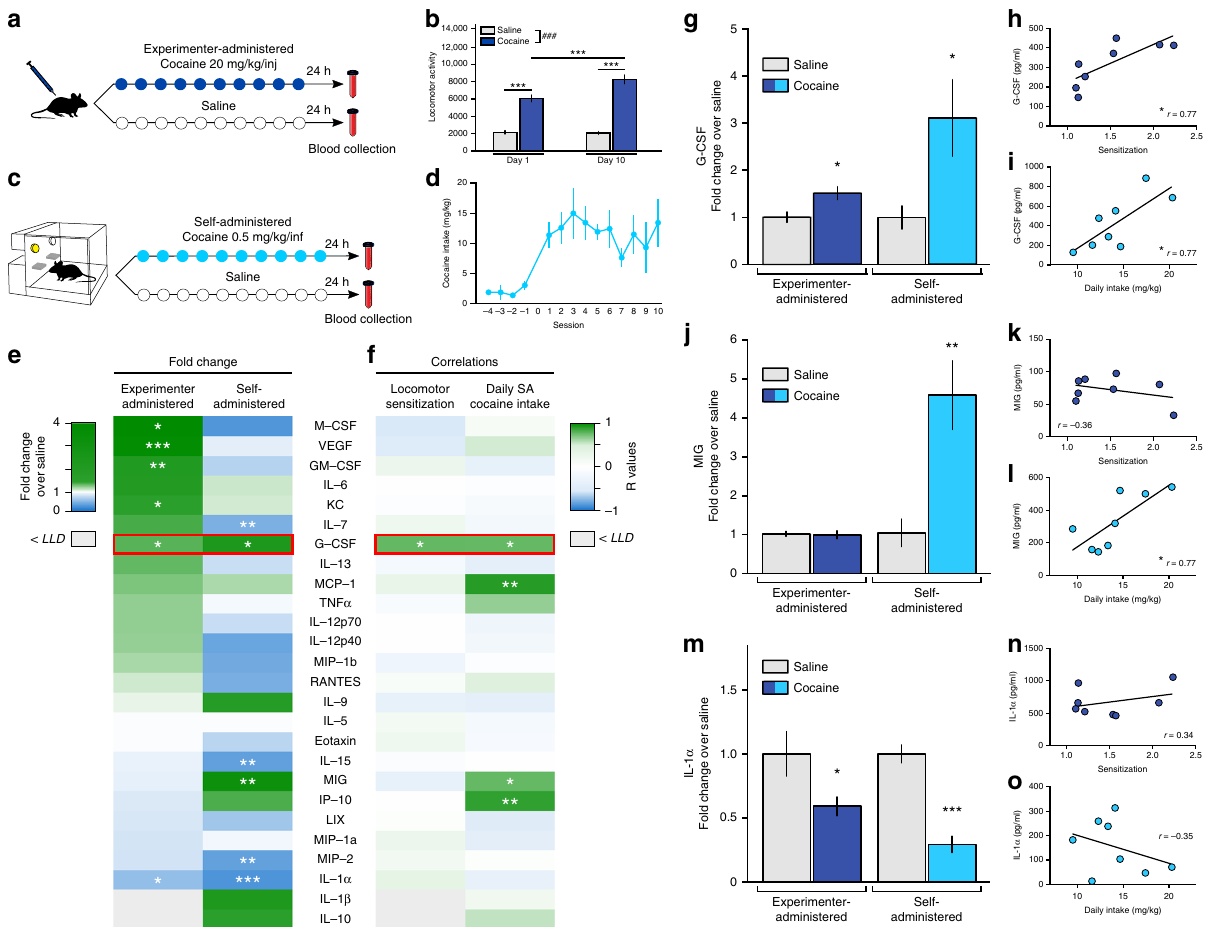
Fig. 1 Serum multiplex analysis after self- and experimenter-administered cocaine in mice. a Timeline of experimenter-administered chronic cocaine injections. b Cocaine resulted in robust locomotor sensitization ( n = 10 saline, 9 cocaine; two-way ANOVA – time: F (1,17) = 7.795, p = 0.013; cocaine treatment: F (1,17) = 326.5, p < 0.0001; interaction: F (1,17) = 9.035, p = 0.0080; p < 0.001 vs control). c Timeline of cocaine self-administration in mice (saline: n = 6 saline; cocaine: n = 10). d Average daily intake of cocaine across self-administration sessions. e Multiplex serum analysis of 32 chemokines, cytokines, and growth factors after experimenter- or self-administered cocaine. For each analyte, the heatmap depicts fold-change values compared to the respective saline group. Raw pg/ml values for each analyte and exact p values are available in Supplementary Data 1. f Correlation heatmap of individual analyte levels with either locomotor sensitization (Day 10/Day 1) or daily intake of cocaine. Exact r values for each analyte and exact p values are available in Supplementary Data 2. g G-CSF is increased after both experimenter- (two-tailed Student ’ s t -test; t (24) = 2.48, p = 0.020) and self-administered cocaine (t (9.40) = 2.51, p = 0.032), and G-CSF levels correlate with both h locomotor sensitization (Pearson ’ s r = 0.771, p = 0.025) and i daily intake of self-administered cocaine (r = 0.768, p = 0.026). j MIG is increased only after self-administered cocaine (t (10.3) = 3.74, p = 0.0036), and k , l individual MIG levels correlate only self-administered cocaine (r = 0.766, p = 0.027). m Levels of IL-1 α are decreased after both experimenter-delivered (t (13.6) = 2.19, p = 0.047) and cocaine self-administration ( t (13) = 7.29, p < 0.0001), however n , o IL-1 α levels did not correlate with either behavior. Data represented as mean ± s.e.m. (* p < 0.05, ** p < 0.01, *** p < 0.001 for Holm – Sidak post-hoc tests and t